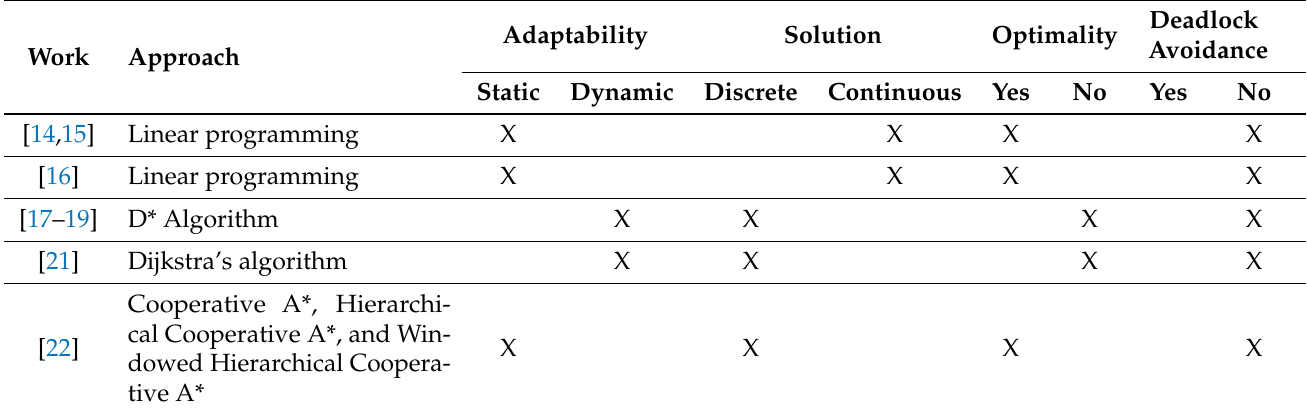
Table 1. Comparison of the related